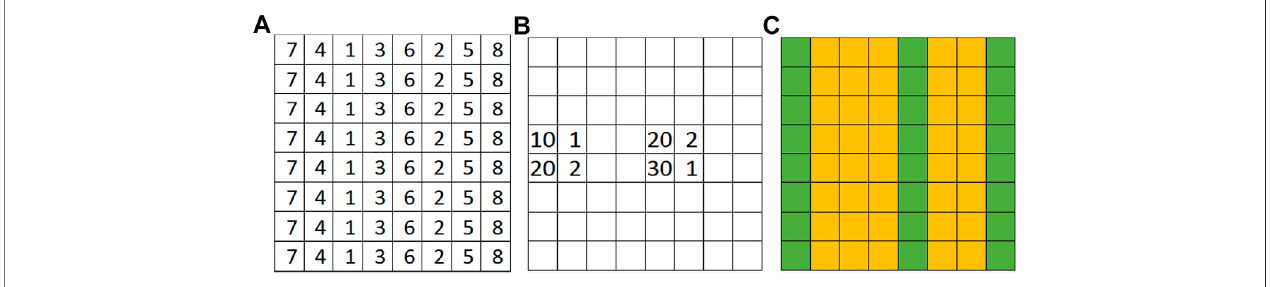
FIGURE1| Anillustrationproblemexample. (A) Spatialpotential fi eld(elevation) (B) Partiallyobservednon-spatialfeaturevalues (C) Groundtruthclasses(greenfor dry, orange for fl ood).